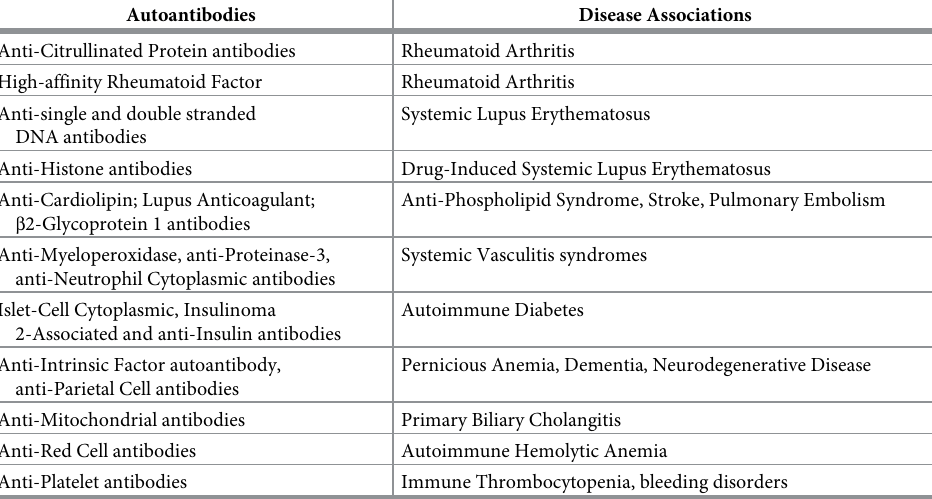
Autoantibodies Disease Associations Anti-Citrullinated Protein